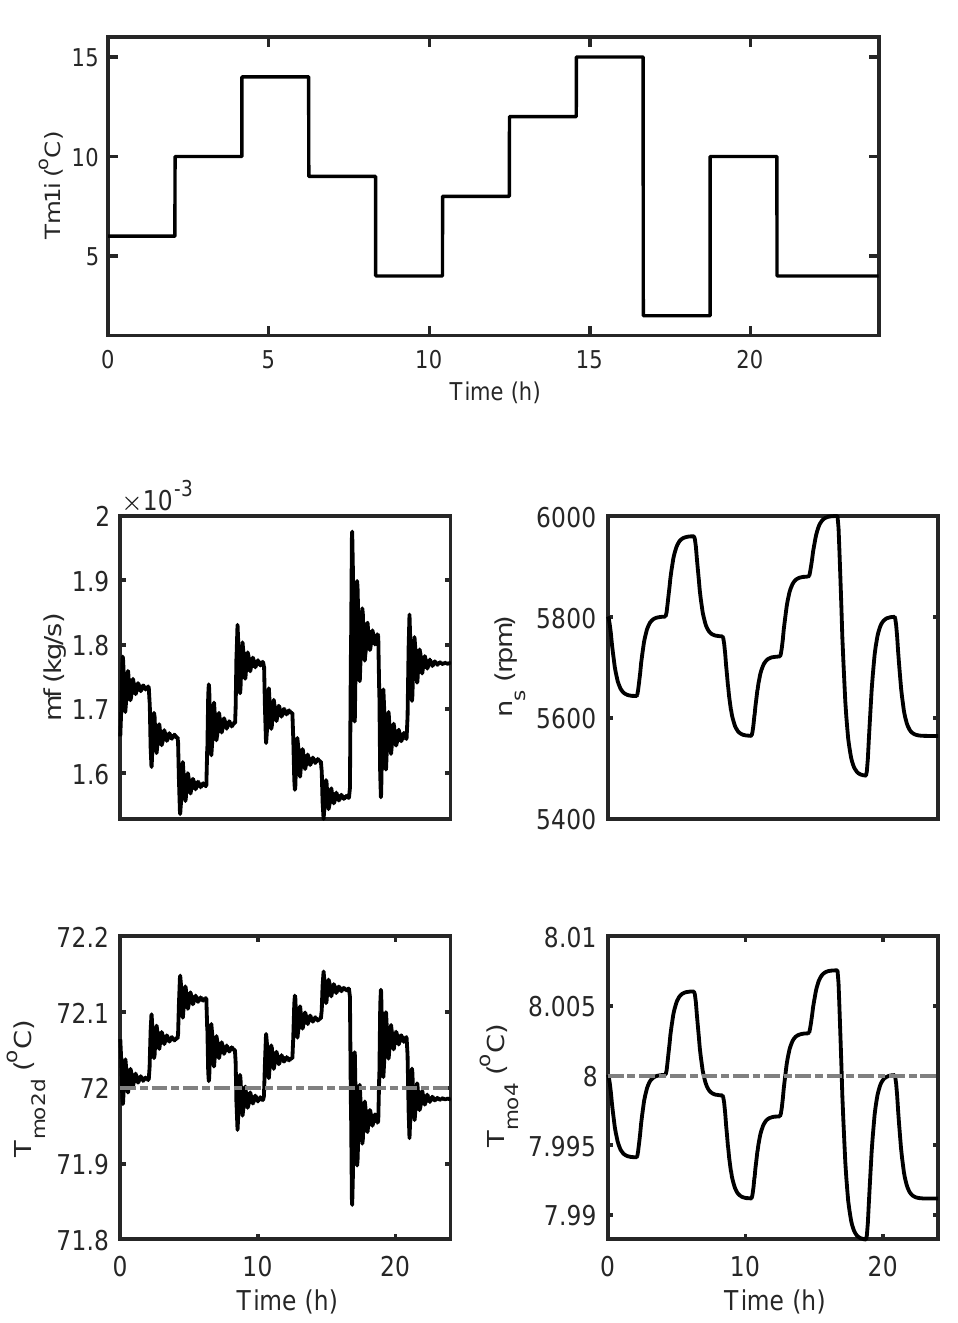
Figure 5. Process disturbance is the inlet milk temperature, T m1i ( top panel ). Controlled outputs are the temperature at the outlet of the holding tube, T mo2d ( bottom left panel ) and milk temperature at the outlet of the fourth heat exchanger, T mo4 ( bottom right panel ). Set-points for both T mo2d and T mo4 are reported with a grey dash-dotted line; manipulated inputs are fuel flow rate at boiler, m f ( middle left panel ), and rotating speed at the refrigeration rate, n s ( middle right panel ).